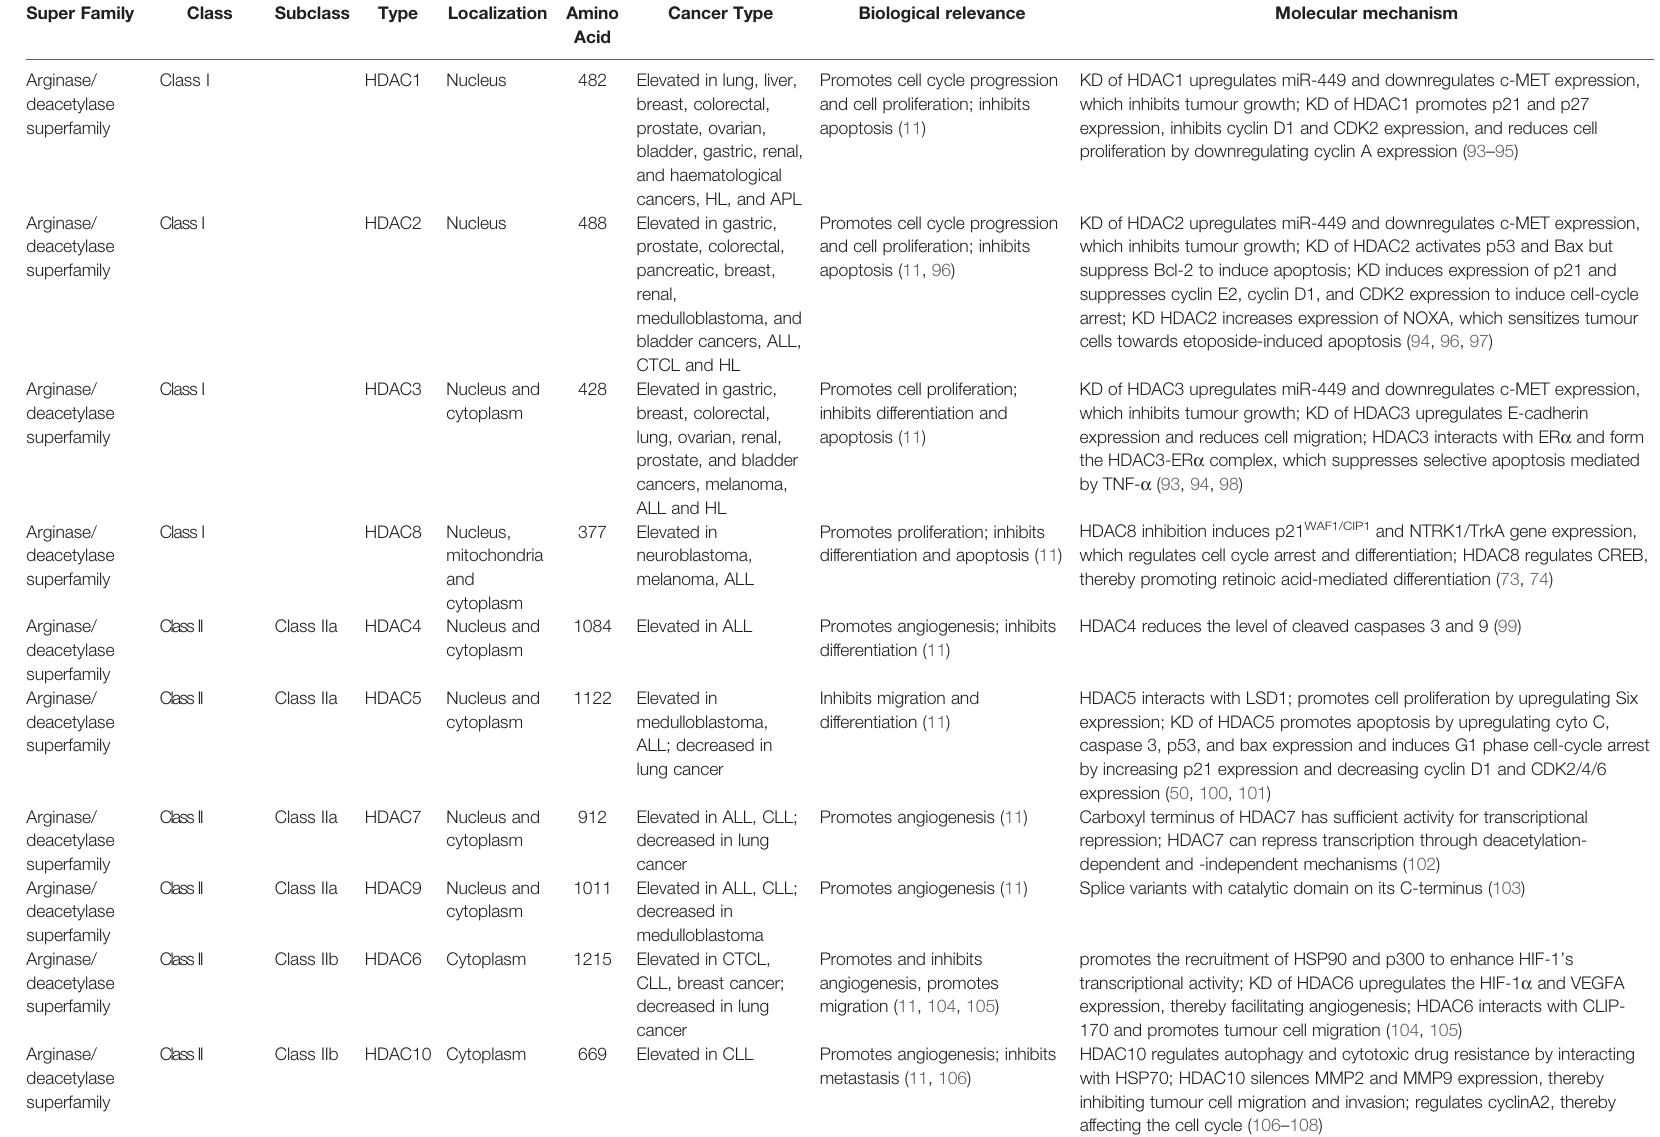
TABLE 1 | Summary of histone